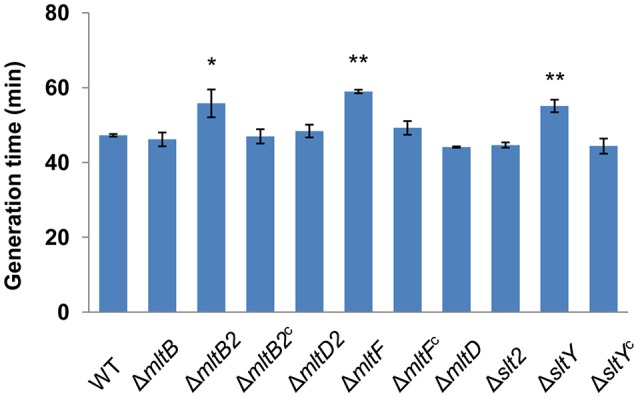
Effects of LTs on cell growth. The generation times for different strains were calculated from the OD600 values. ΔmltB2c, ΔmltFc and ΔsltYc represent ΔmltB2, ΔmltF and ΔsltY that were complemented with pHG101 in trans, respectively. Results are averages for at least three replicates, and the error bars represent standard derivation (SD) (*P < 0.05 and **P < 0.01, respectively; two-tailed t-test).